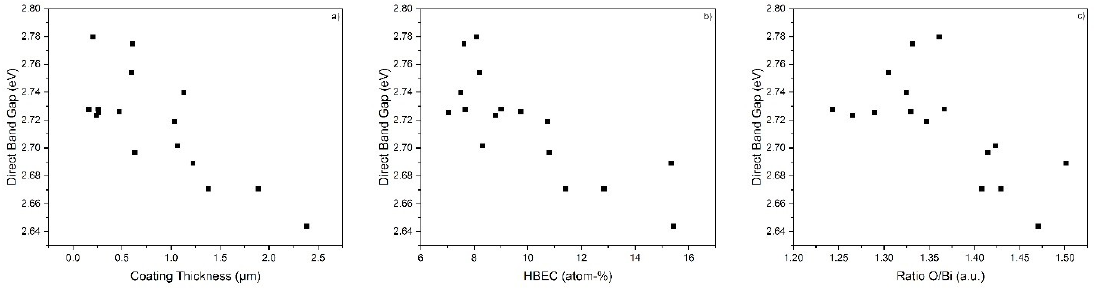
Figure 8. Direct band gap plots vs. ( a ) coating thickness, ( b ) atomic concentration of HBEC, and ( c ) oxygen/bismuth ratio.